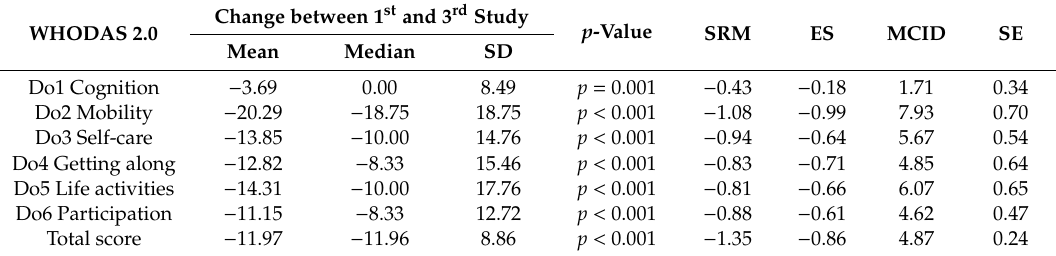
Table 6. Responsiveness of the 36-item WHODAS